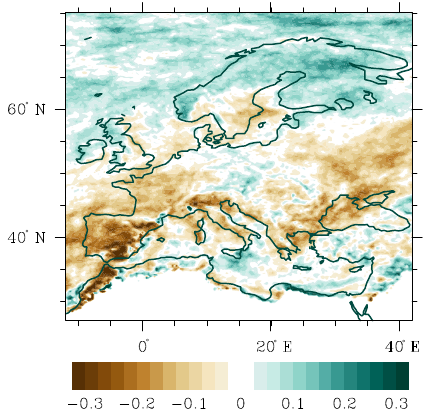
Figure 7. Fractional change between + 2 and + 1.5 ◦ C ensem- bles (ratio of the difference and the climatological mean in the + 1.5 ◦ C experiment) for 10-year return values of 3-hourly precip- itation ( × 100%) in CAM5.1.2_0.25. Differences in precipitation were estimated for the values larger than 1mmday − 1